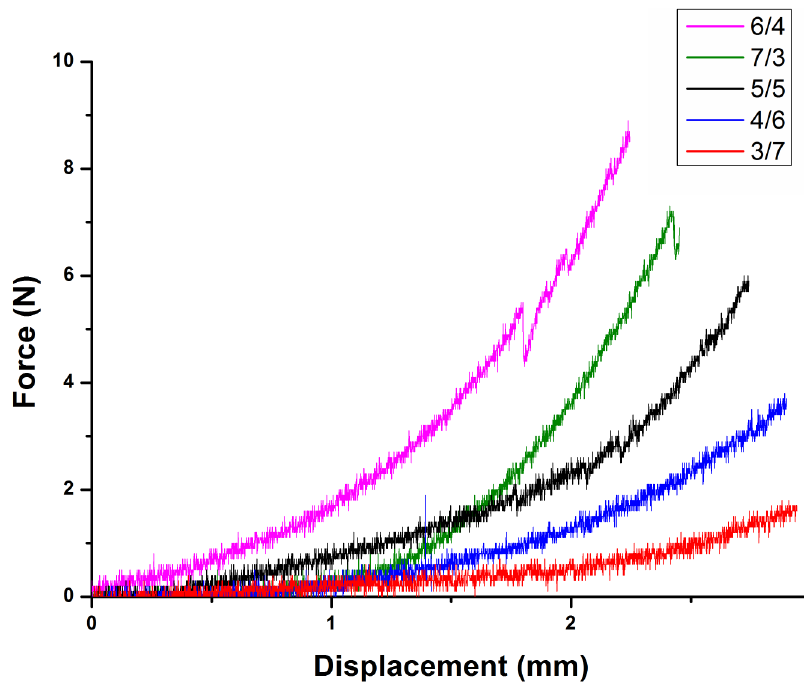
Figure 7. Force-displacement curves for all the compositions of dextran/gelatin hydrogels.